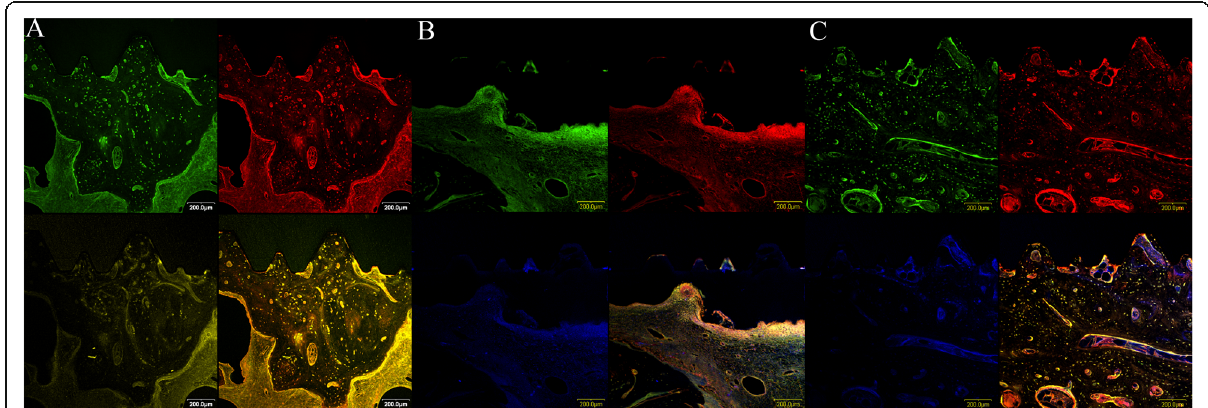
Fig. 3 Confocal image showing the polychromic vital staining of Tetracycline HCl (3 and 11 weeks), Calcein (6 weeks), and Alizarin Red stain (9 weeks). No separable chronologic regenerative fluorescence bands could be observed in the three groups. a MSCs+PRP+PCL-TCP, b PRP+PCL-